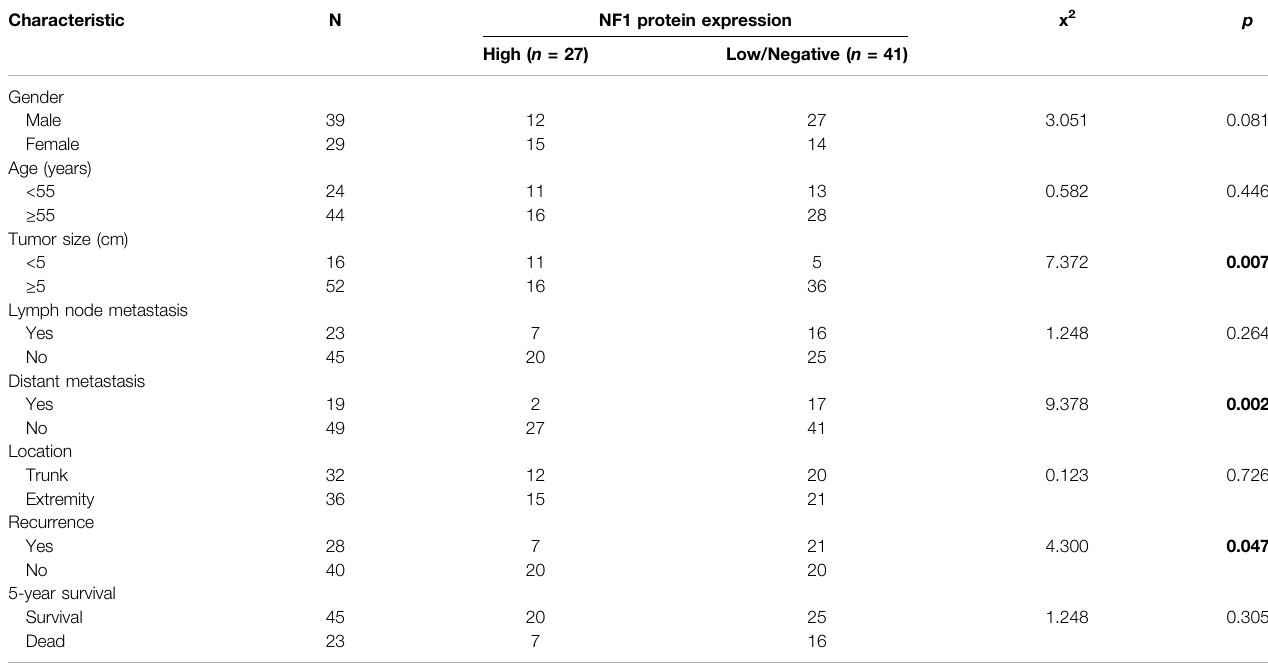
TABLE 2 | Correlation between the NF1 protein expression and clinicopathological characteristics of UPS patients Characteristic